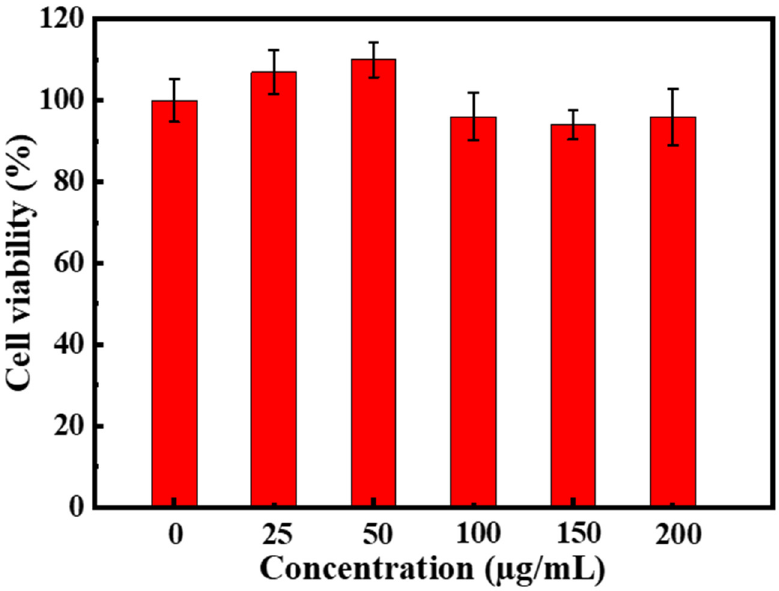
Figure 8. Cell viability of HUVECs treated with Fe 3 O 4 @SiO 2 @Au/PDA nanochains at different con- centrations.